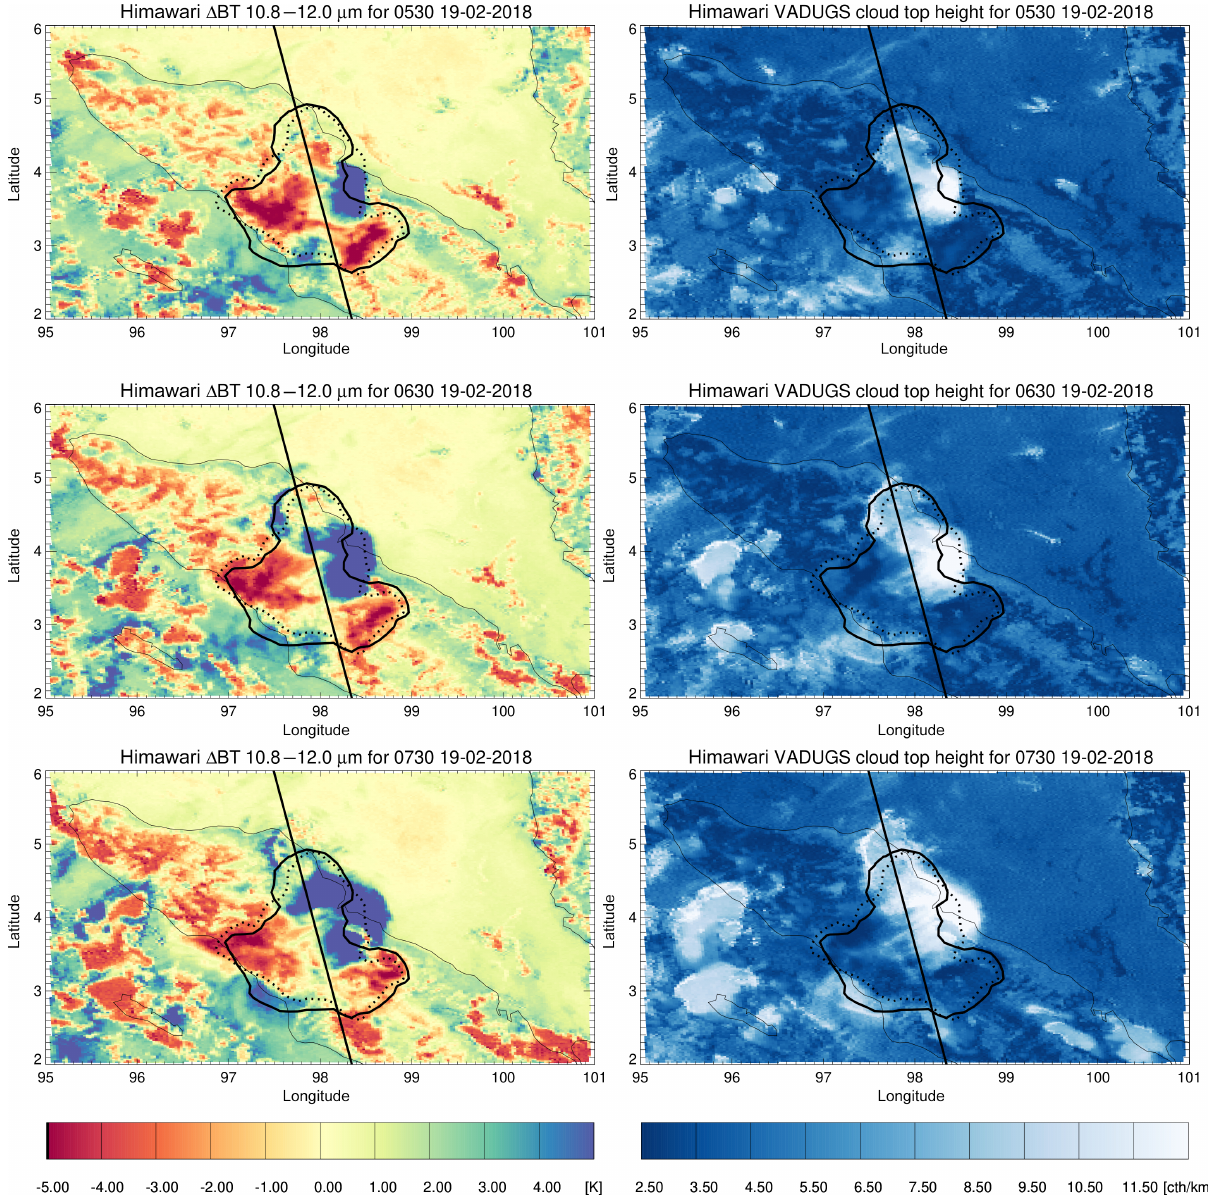
Figure 4. Himawari-8 VADUGS cloud heights (right) and 10.8–12.0 µm (cid:49) BTs (left) for every hour between 02:30 and 07:30UTC. The line denotes the CALIPSO overpass track. The solid and dotted contours denote outline of TROPOMI>10DU SO 2 columns and TROPOMI AAI>0 value, as shown in Fig.